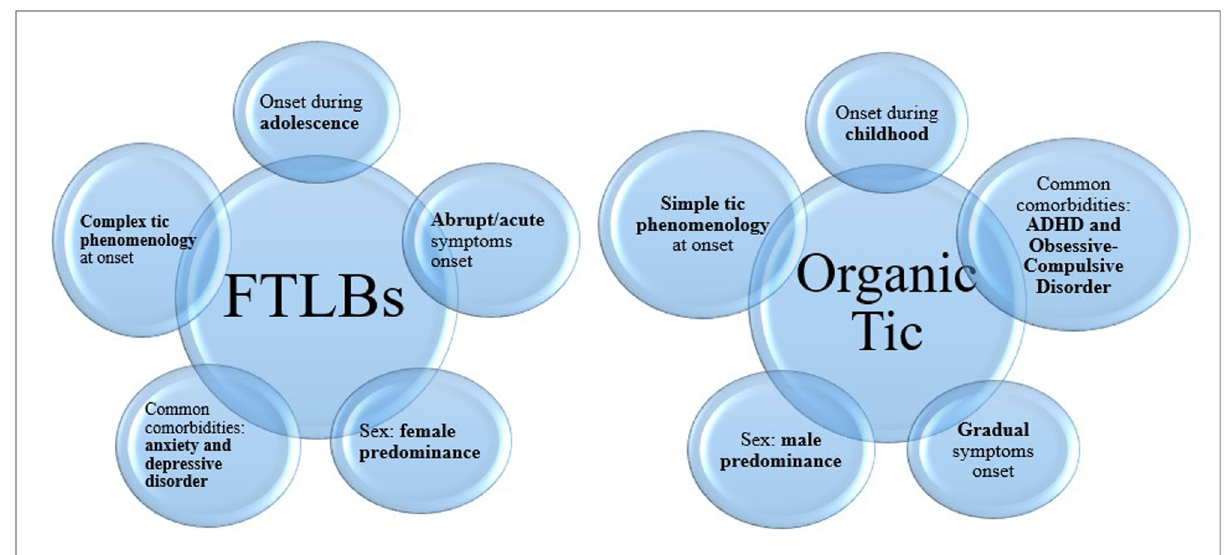
FIGURE 1 Phenomenological differences between organic tics and